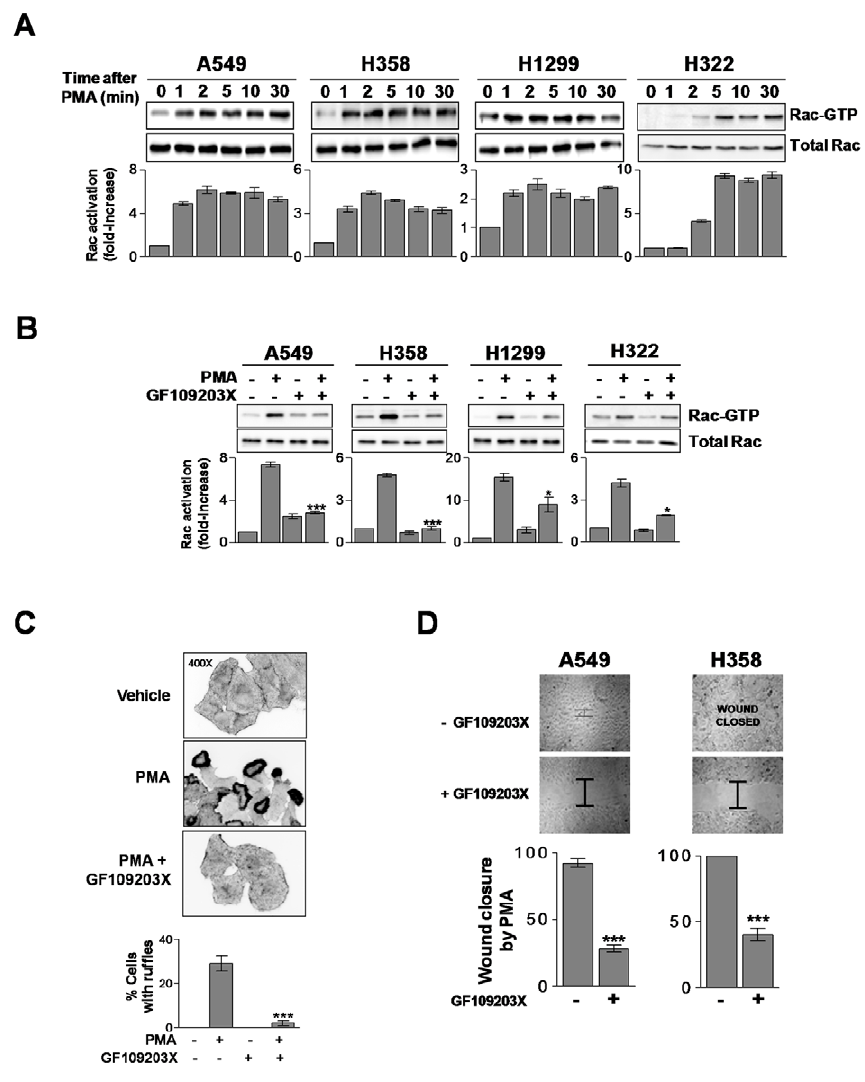
Figure 1. PMA activates Rac responses in NSCLC cells. A. NSCLC cells were serum starved for 24 h and treated with PMA (100 nM) for different times, and Rac-GTP assays determined using a pull-down assay. A representative experiment is shown. The fold-induction in Rac-GTP levels normalized to total Rac at time=0, as determined by densitometry, is represented in the bottom graphs. Data are expressed as mean 6 S.D. (n=3). B. Effect of the pan-PKC inhibitor GF109203X (5 m M, 30 min) on Rac activation by PMA (100 nM, 2 min).The fold-induction in Rac-GTP levels normalized to total Rac at time=0, as determined by densitometry, is represented in the bottom graphs. Data are expressed as mean 6 S.D. (n=3). *, p , 0.05; ***, p , 0.001. C. A549 cells were treated with PMA (100 nM, 30 min), fixed, and stained with phalloidin-rhodamine. Top , representative micrographs are shown (n=3). Bottom , quantification of cells bearing ruffles, expressed as mean 6 S.D. of 3 individual experiments. ***, p , 0.001. D.Confluent monolayers of cells were treated with PMA (100 nM, 30 min) and scraped. Closure of wounds was recorded at 9 h (A549 cells) or 20 h (H358 cells) post-treatment. Experiments were carried out in triplicate plates. Results are expressed as percentage of the closure induced by PMA, and expressed as mean 6 S.E.M. (n=3). ***, p ,